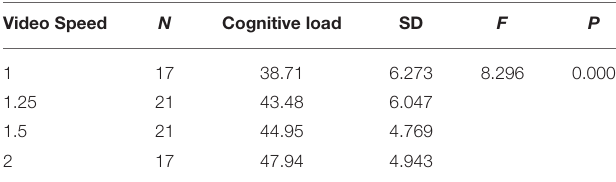
TABLE 5 | Influence of video speed on cognitive load shown by covariance analysis. Video Speed